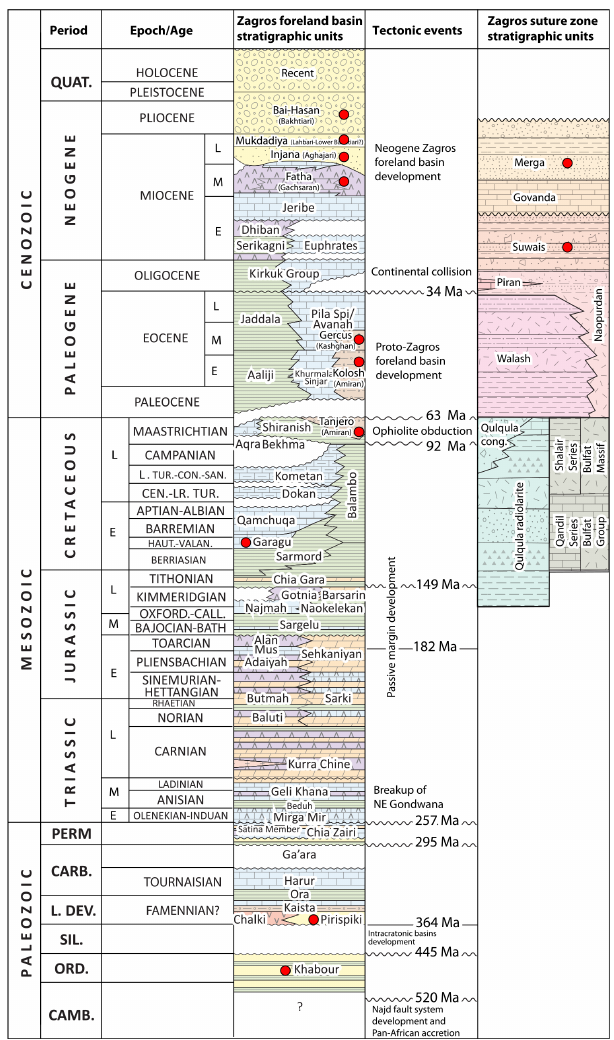
Figure 2. Generalized Phanerozoic stratigraphic column and key tectonic events for the NW Zagros fold–thrust belt and foreland basin, including the suture zone units in the Kurdistan region of Iraq (Sissakian et al., 1997; Sharland et al., 2001; English et al., 2015). The names in parentheses represent the potential equivalent formation names in Iran. Red circles represent stratigraphic units that were addressed in this